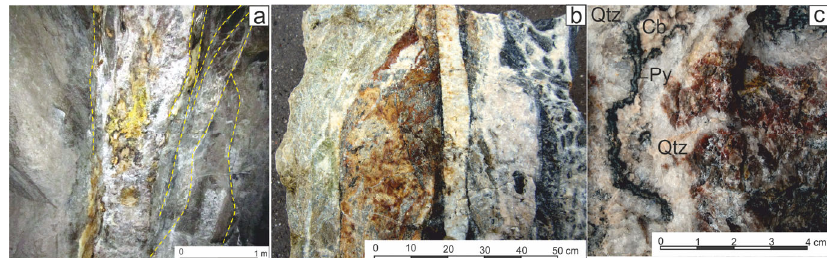
Figure 3. Macrostructures of the quartz–carbonate–sulfide vein with synchysite. ( a ): The synchysite- bearing vein mainly consists of quartz–carbonate and is locally separated from the albitized and graphitized gneiss host rocks by small structures of brittle deformation (yellow dashed lines). Yellow–green coatings on the vein surface, which comprise a mixture of jarosite and secondary uranium minerals, indicate the presence of fragments of older uranium mineralization. ( b ): The vein comprises several generations of calcite and quartz, and it encloses abundant clasts of host rocks along its edges. ( c ): Single generations of predominantly quartz and calcite sections of the vein are very often separated by up to 5 mm thick accumulations of authigenic pyrite and marcasite. The synchysite is bound to quartz ‐ rich sections of the vein that are strongly colored by hematite. Expla ‐ nations: Cb: Carbonate; Qtz: quartz; Py: pyrite.